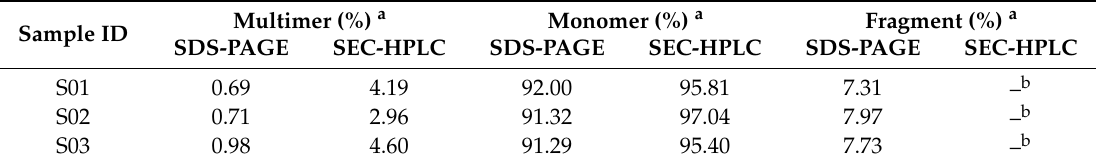
Figure 1. Purity and molecular weight determination of rhIL-12. ( A , B ) Purity determination of rhIL-12 bulks (S01, S02 and S03) by non-reduced SDS-PAGE and SEC-HPLC. ( C , D ) Molecular weight of p40 fragments by MS for rhIL-12 sample S01. ( E ) Molecular weight of p35 by MS for rhIL-12 sample S01. ( F ) Molecular weight of intact p40 by MS for rhIL-12 in-house reference.